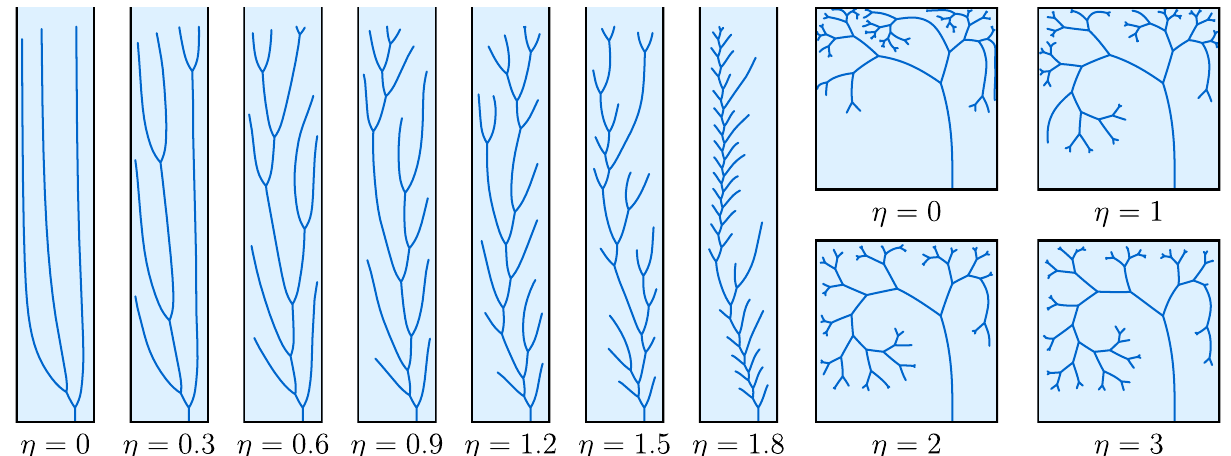
Figure 4. Comparison of the Laplacian and Poissonian networks for different η exponents. On the left, Laplacian networks in a channel with reflective side walls and flux of the field coming from the top. On the right, Poissonian networks in a square box with reflective side and top walls and non-zero source term. In the latter case, each of the networks has the same total sum of the lengths of the branches. The networks grow from a single seed initially placed at 3/4 of the channel width. Fingers can bifurcate with the velocity criterion a 1 > 0.8 in the Laplacian case and with the bimodality criterion a 3 / a 1 < − 0.1 in the Poissonian